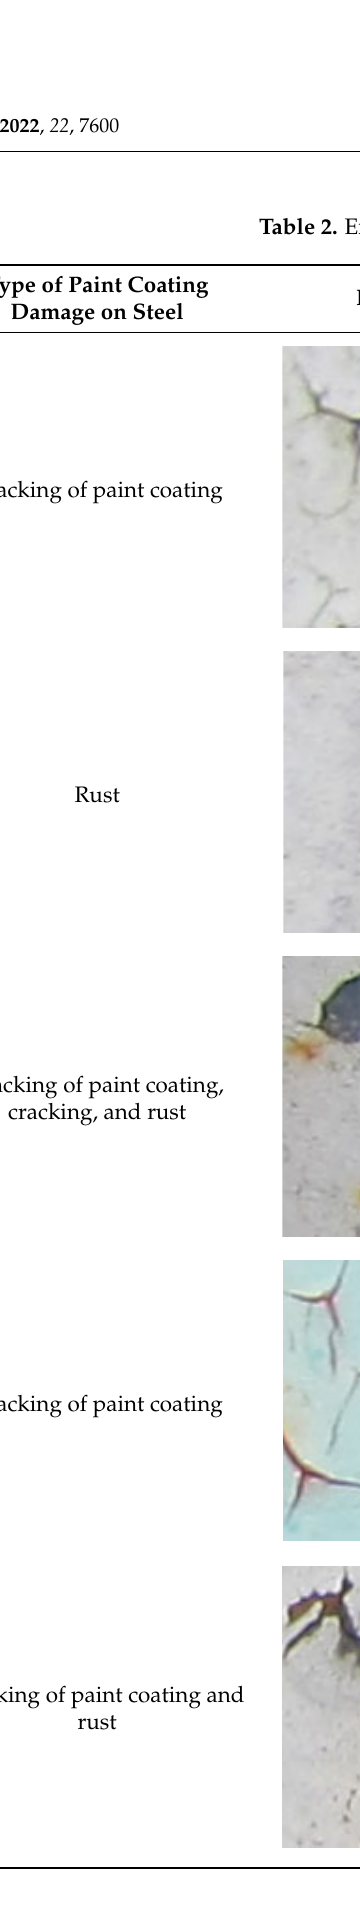
Table 3. Results of paint damage and rust segmentation. Type of Paint Coating Damage on Steel